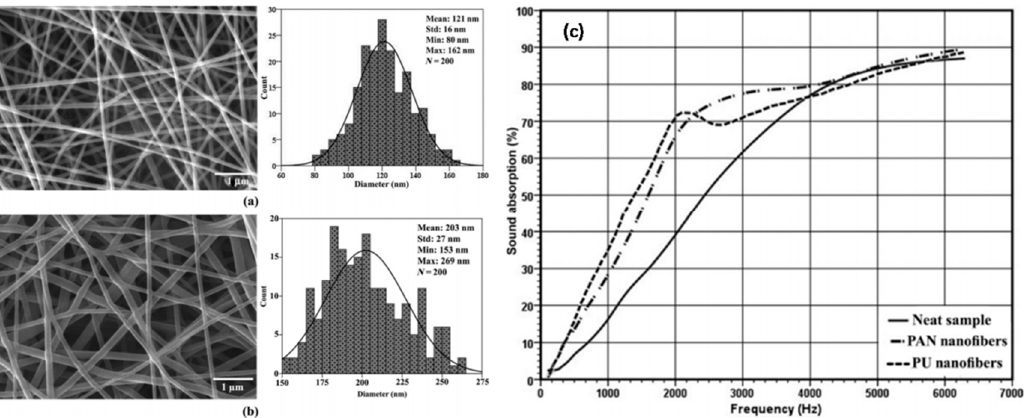
Figure 15. SEM images (left) and diameter distribution (right) of ( a ) PAN-NFs and ( b ) PU-NFs. ( c ) Sound absorption curves of neat sample (without nanofibers), nonwoven with PAN-NFs and nonwoven with PU-NFs.